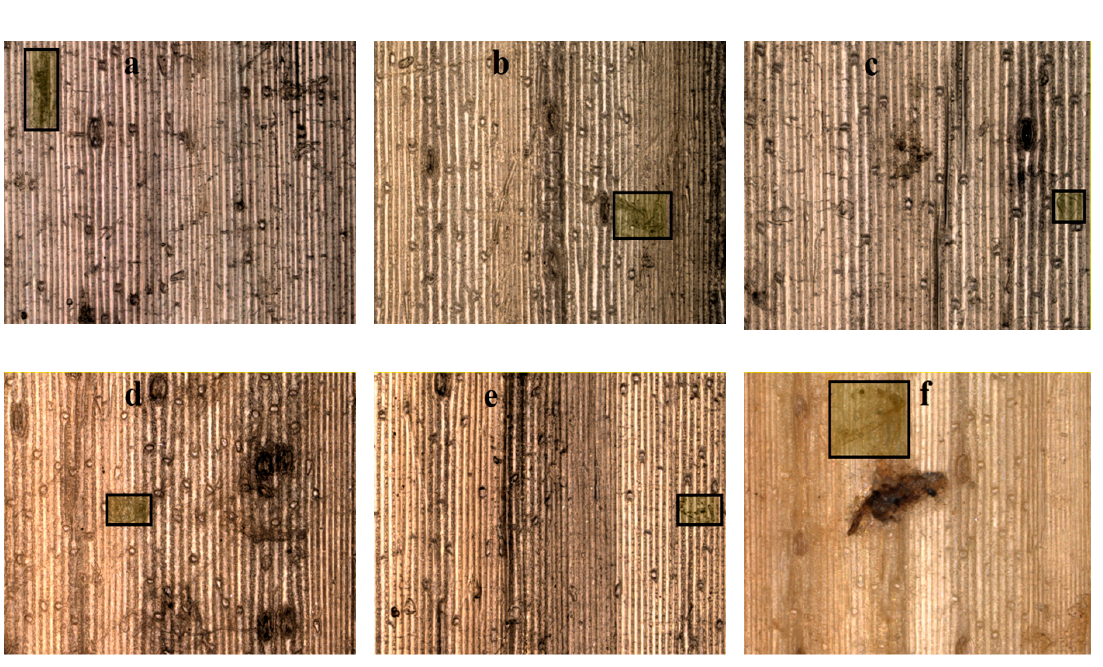
Figure 16. Measurement site of the wheat stalk over time with wet rotary tillage. Note: ( a – f )—2, 3, 4, 5, 6, 7 sampling with dry rotary